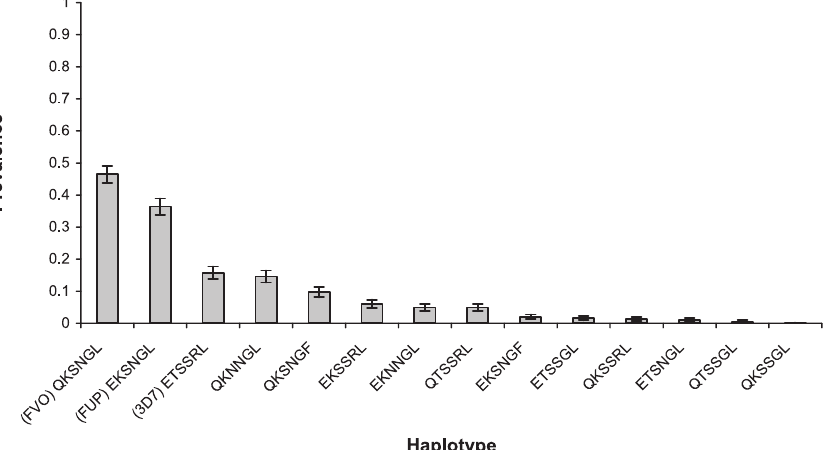
Figure 1. Prevalences of 14 MSP-1 19 Haplotypes in a Cohort from Bandiagara, Mali Infections could have multiple haplotypes, thus haplotype prevalences do not sum to one. Haplotypes corresponding to the FVO, FUP, and 3D7 strains are indicated. Bars indicate 95%